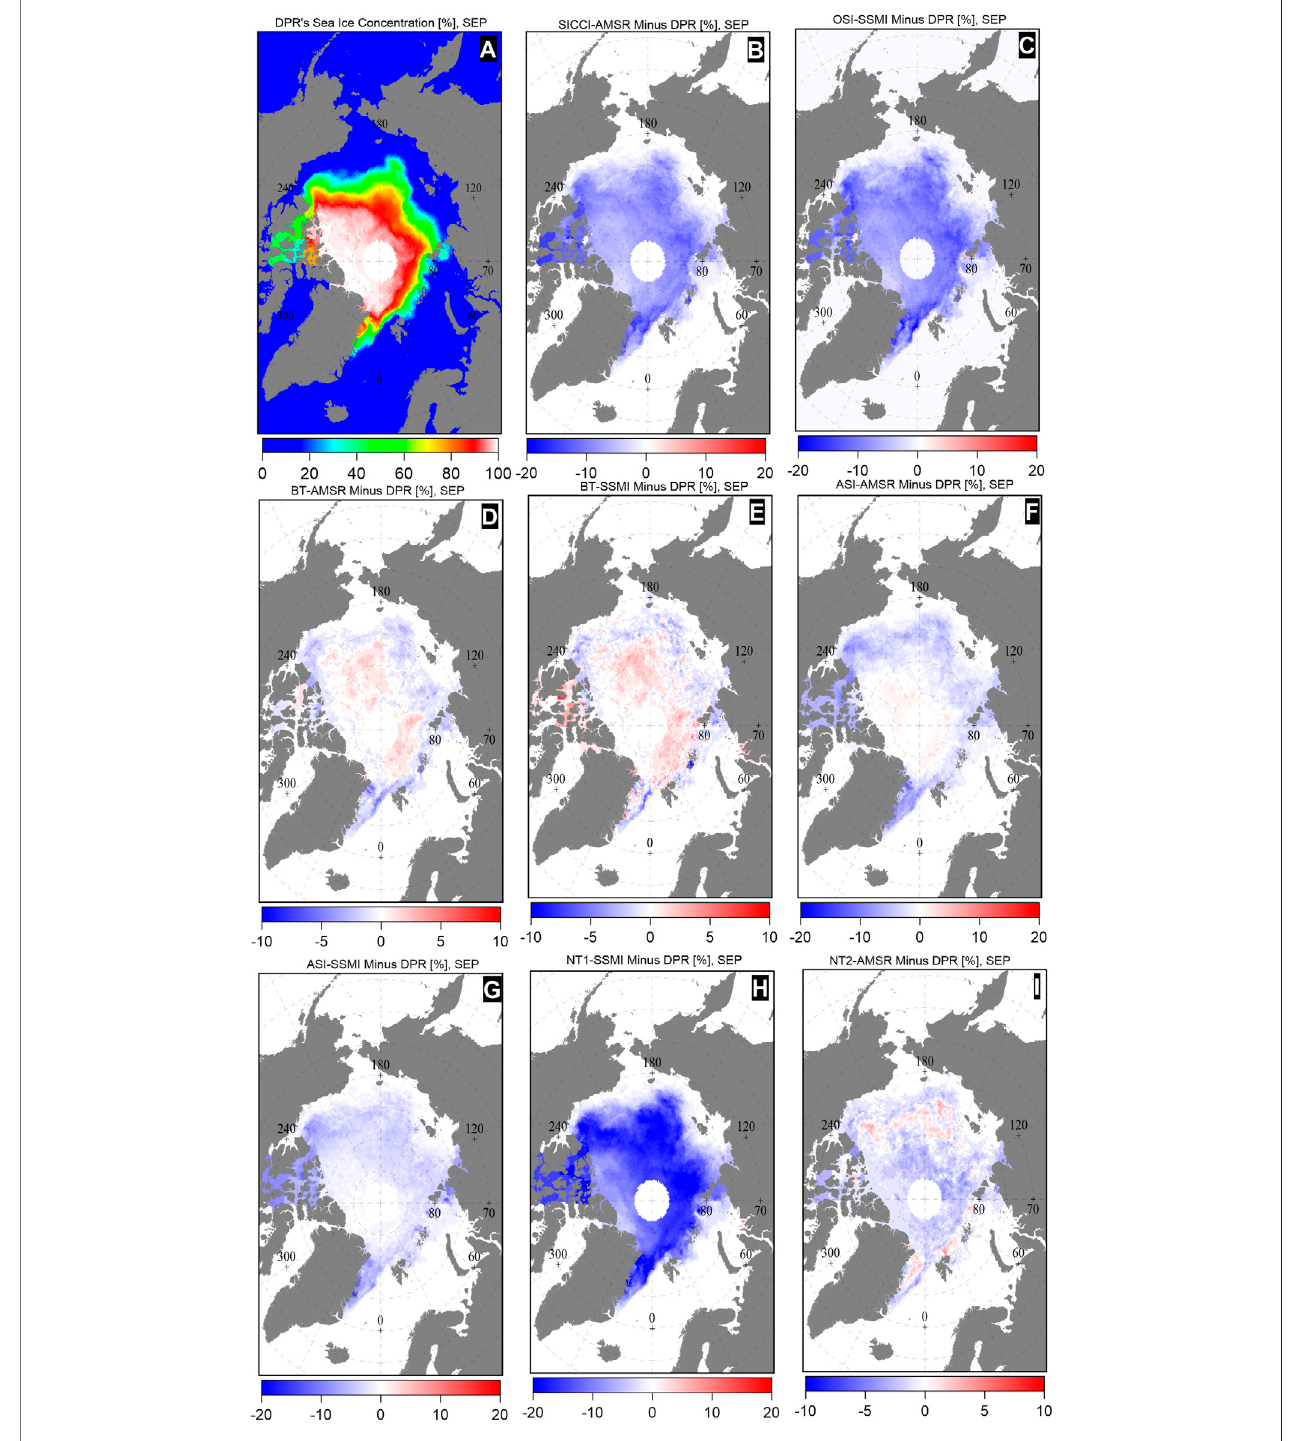
FIGURE5| Maps ofdifferences betweenthe multi-annual averagemonthlysea ice concentration ofDPR-AMSR and other eight sea iceconcentrationdata sets in September (2002 – 2015): SICCI-AMSR (B) , OSI-SSMI (C) , BT-AMSR (D) , BT-SSMI (E) , ASI-AMSR (F) , ASI-SSMI (G) , NT1-SSMI (H) , and NT2-AMSR (I) . (A) is the sea ice concentration map of DPR-AMSR. Differences were only computer for DPR-AMSR sea ice concentration > 15%.